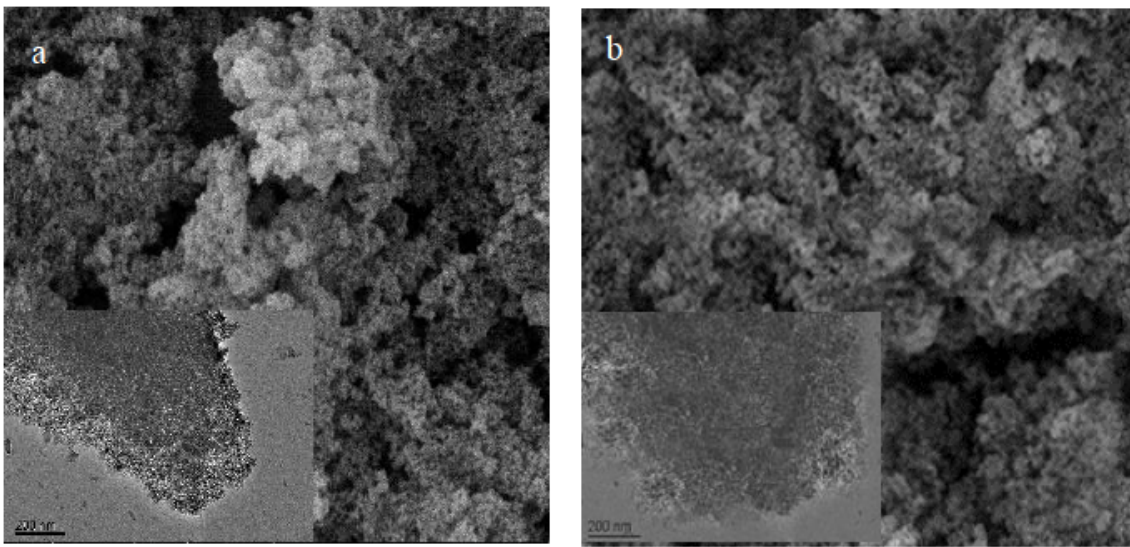
Figure 1: SEM image of SiO 2 (AG) sample (a: hydrophobic; b: hydrophilic) (insets are TEM images)